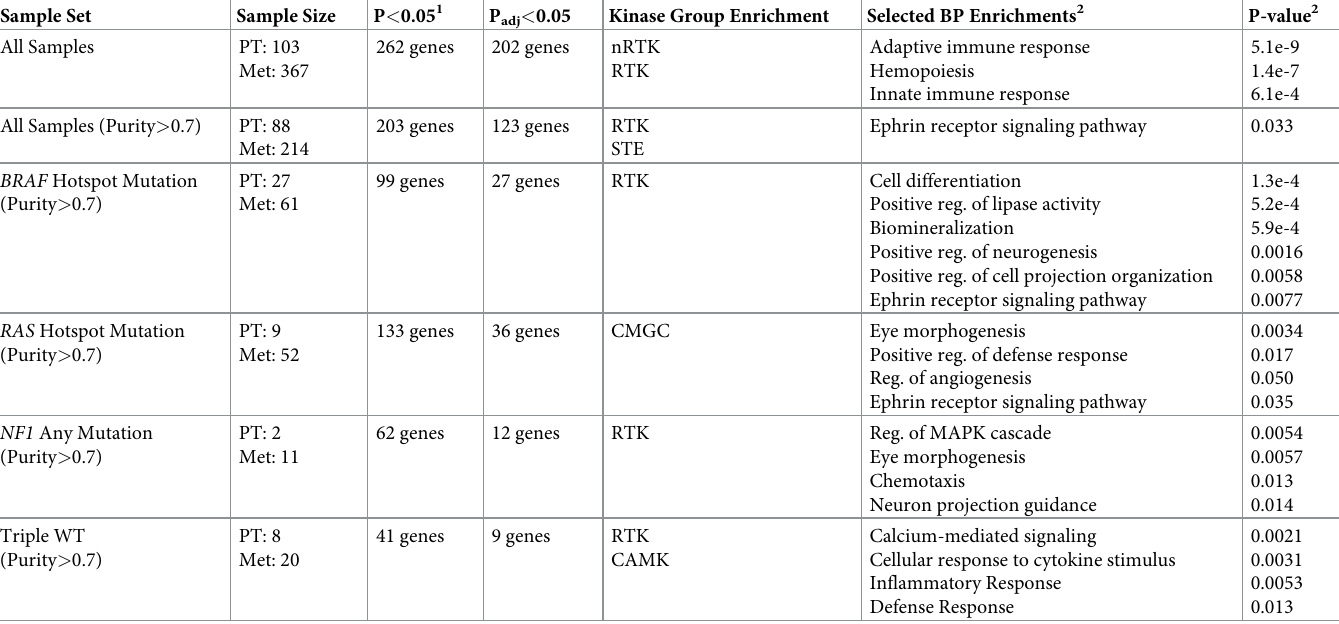
Table 3. Summary of kinase differential expression results. Sample